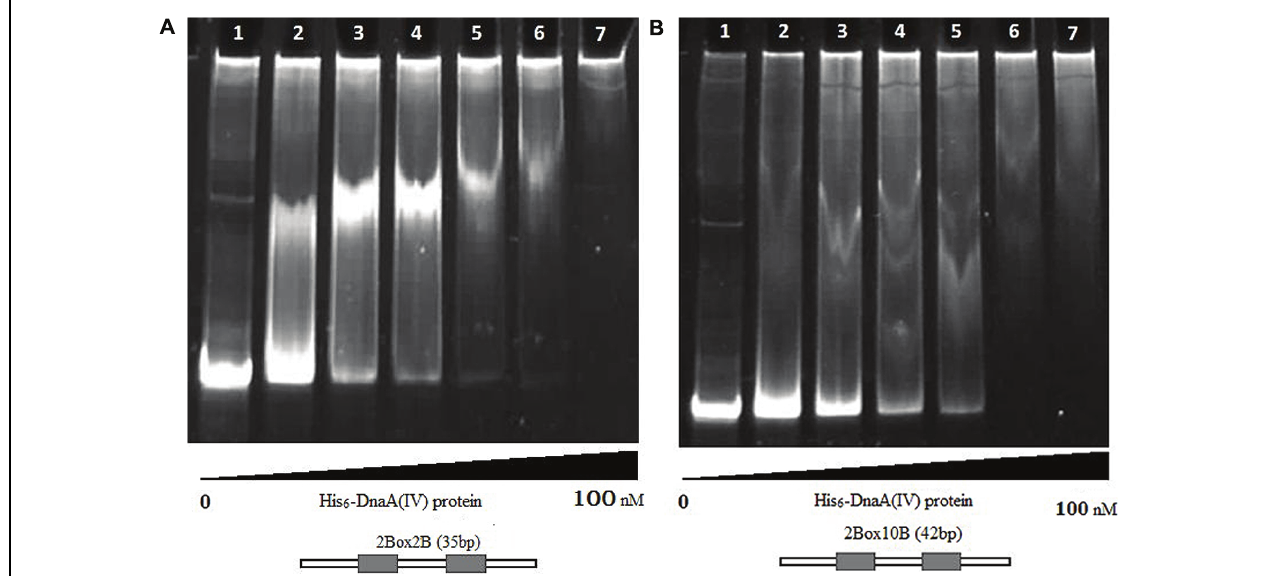
FIGURE 5 | Interaction of the His 6 -DnaA (IV) protein with the circular and linear chromosomes DnaA boxes (8% gel). (A) Interaction of the His 6 -DnaA (IV) protein with the circular chromosome DnaA boxes. (1) Double-stranded oligonucleotides [Cbox23F:Cbox23R, without DnaA (IV)]. (2–7) His 6 -DnaA (IV) binding to double-stranded oligonucleotides (2: 5.0; 3: 10.0; 4: 25.0; 5: 50.0; 6: 75.0; 7: 100.0 nM). 2Box2B (35 nt): the 35-nt double-stranded oligonucleotides containing two DnaA boxes with 2 nt space. (B) Interaction of the His 6 -DnaA (IV) protein with the linear chromosome DnaA boxes. (1) double-stranded oligonucleotides [Lbox23F:Lbox23R, without DnaA (IV)]. (2–7) His 6 -DnaA (IV) binding to double-stranded oligonucleotides (2: 5.0; 3: 10.0; 4: 25.0; 5: 50.0; 6: 75.0; 7: 100.0 nM). 2Box10B (42 nt): the 42-nt double-stranded oligonucleotides containing two DnaA boxes with 10 nt